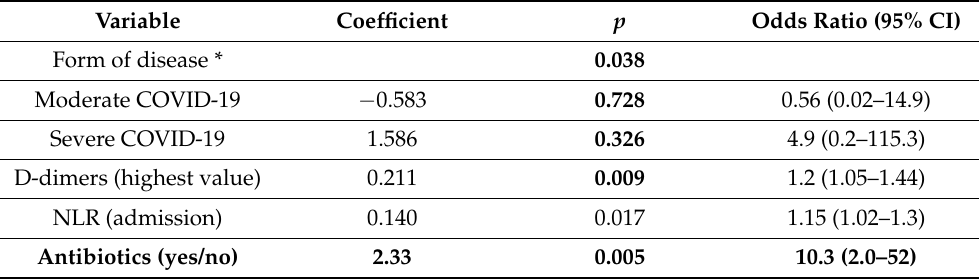
Table 6. The association of antibiotic treatment with death in the patients without reasons for prescription, after the adjustment for the prognostic factors (logistic